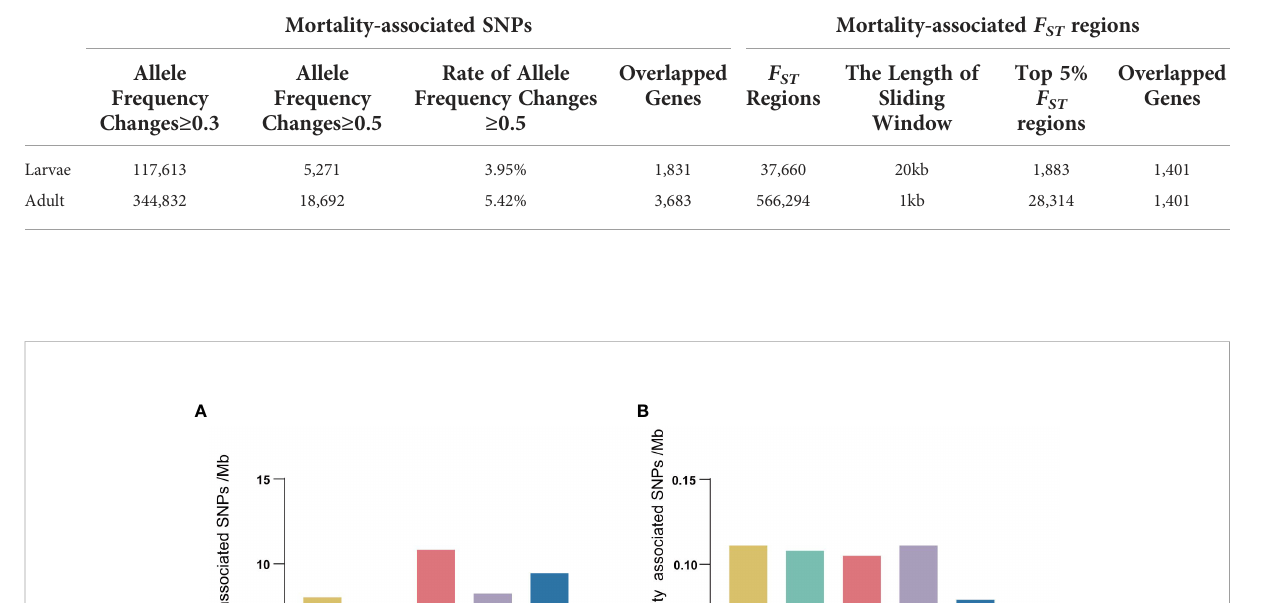
TABLE 2 Number of mortality-associated SNPs and F ST outlier regions in larval and adult